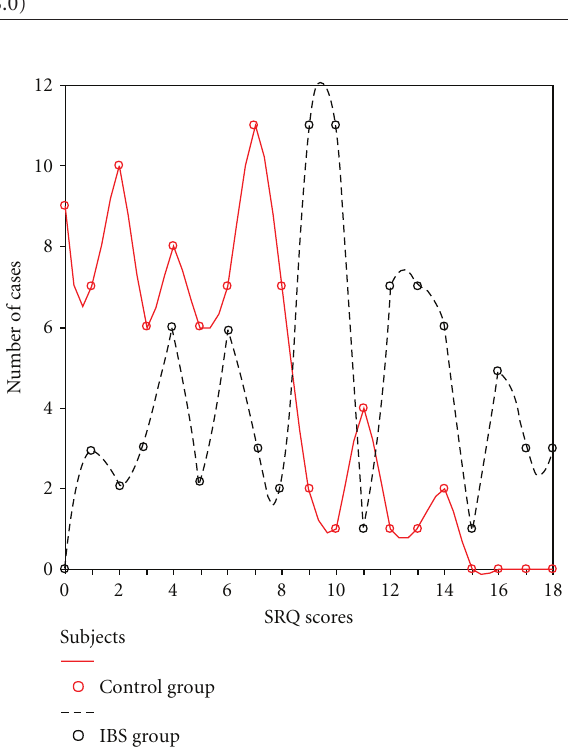
Figure 1: Comparison of SRQ-scores in IBS patients and